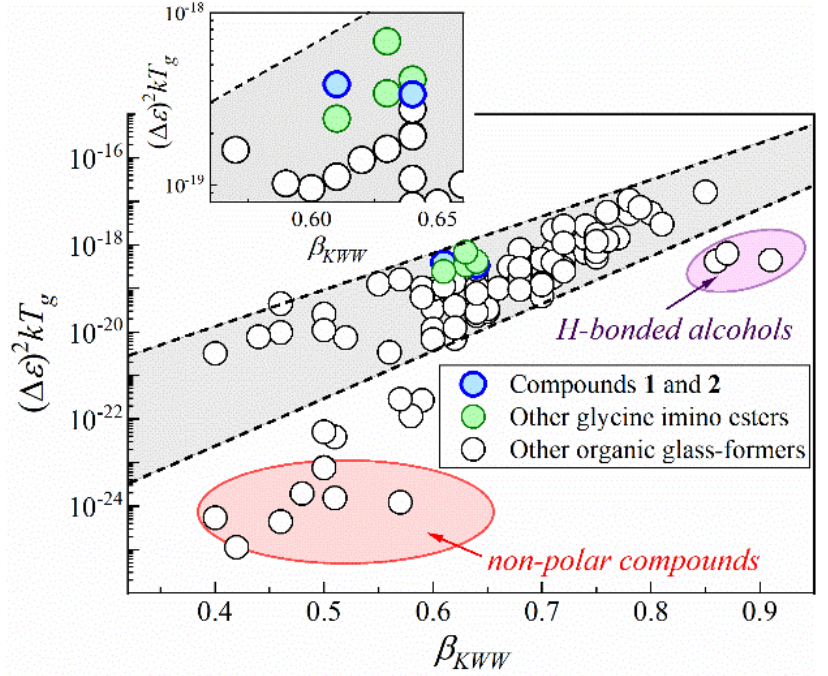
Figure 5. Fundamental correlation between dielectric strength ∆ ε and the frequency dispersion width of the α -relaxation loss peak demonstrated by plotting kT g ( ∆ ε ( T g )) 2 against β KWW . The herein-studied compounds 1 and 2 , as well as the previously reported glycine imino esters are polar, which makes the empirical relationship useful to determine the significance of hydrogen bonds in these systems. As presented in Figure 5, the near- T g values of ∆ ε and β KWW (obtained from the ∆ ε , α , β parameters of HN fit function, as β KWW = α · β ) can be rationalized by this correlation in the case of glycine imino ester family. It means that these compounds behave like simple van der Waals liquids. In other words, despite the occurrence of intra- and intermolecular hydrogen bonds, weak van der Waals and dipole–dipole interactions have a decisive impact on their molecular dynamics and dielectric properties of glycine imino esters. This conclusion coincides with atypically high d T g /d p values for compounds 1 and 2 . It also supports the hypothesis of self-organization into dimeric structures via BHBs because, in such case, the hydrogen bonding sites are ‘used up’ for the formation of associates. Hence, the performed dielectric and X-ray diffraction studies show that hydrogen bonds are responsible for stiffening of the molecular skeleton and intermolecular self-organization, whereas van der Waals and dipole–dipole interactions control the molecular dynamics and dielectric properties of the medium-sized compounds 1 , 2 and other glycine imino esters. The obtained result also brings us to a general conclusion that (contrary to popular belief) compounds with OH groups may behave like simple van der Waals liquids, particularly when the moieties are involved in the formation of strong intramolecular hydrogen bonds and bifurcated hydrogen